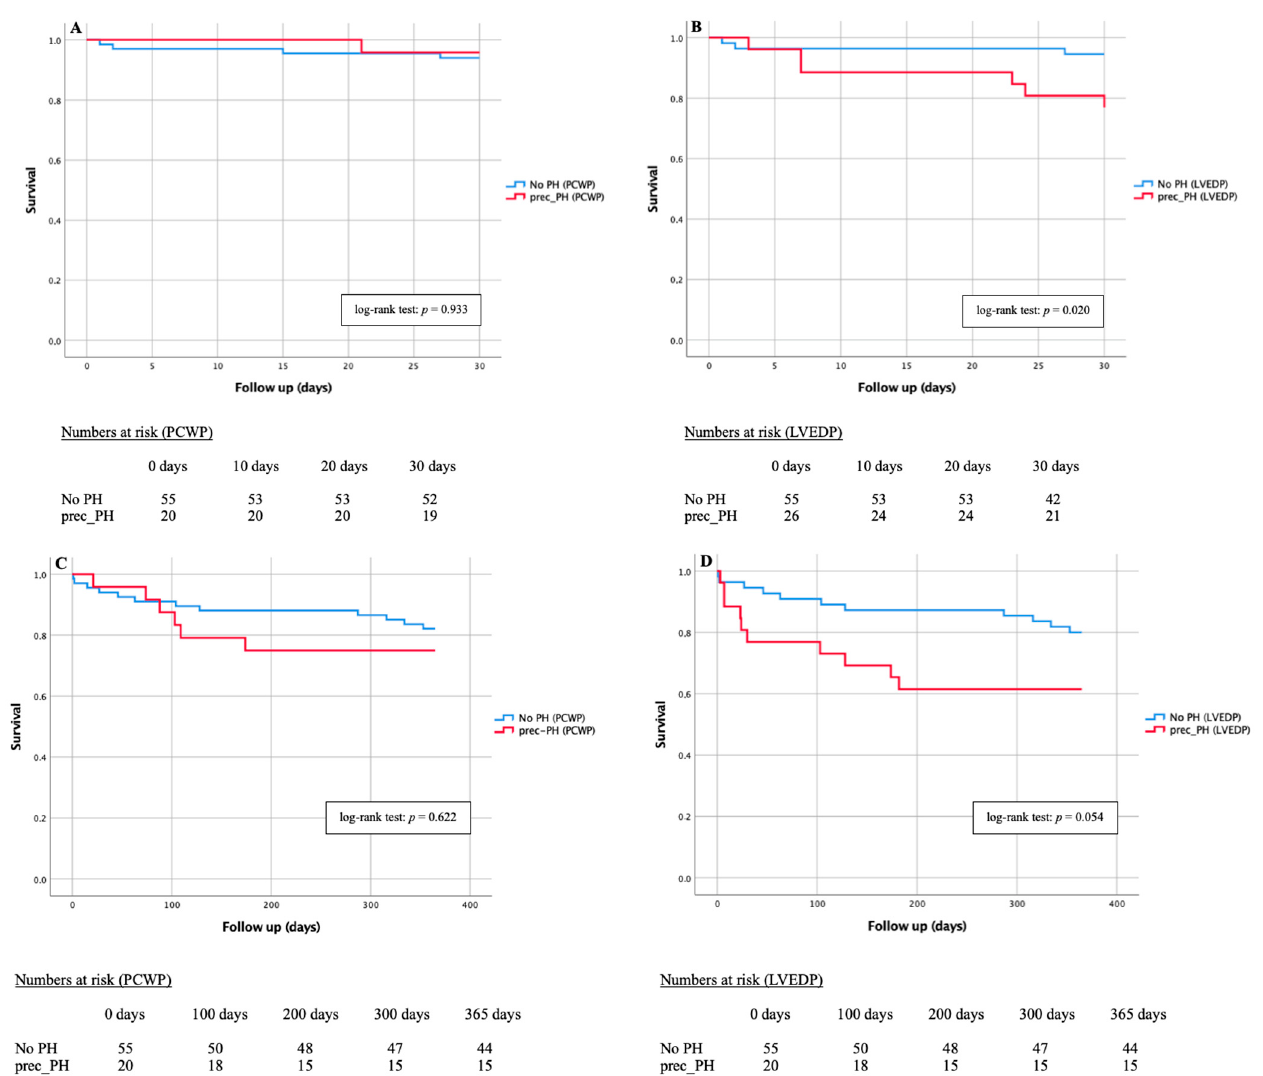
Figure 5. Kaplan-Meier curves of 30-day and 1-year mortality with associated numbers at risk in patients with severe AS diagnosed with pre-capillary PH via PCWP and LVEDP. ( A ) 30-day mortality of No PH vs. pre-capillary PCWP-PH; ( B ) 30-day mortality of No PH vs. pre-capillary LVEDP-PH; ( C ) 1-year mortality of No PH vs. pre-capillary PCWP-PH; ( D ) 1-year mortality of No PH vs. pre-capillary LVEDP-PH. Prec-PH: pre-capillary pulmonary hypertension.